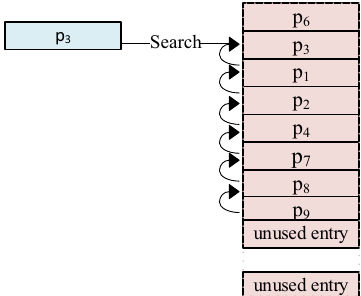
Fig. 4 Deleting the rule in the first